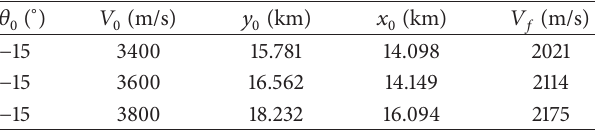
Table 2: Optimal initial position with more severe